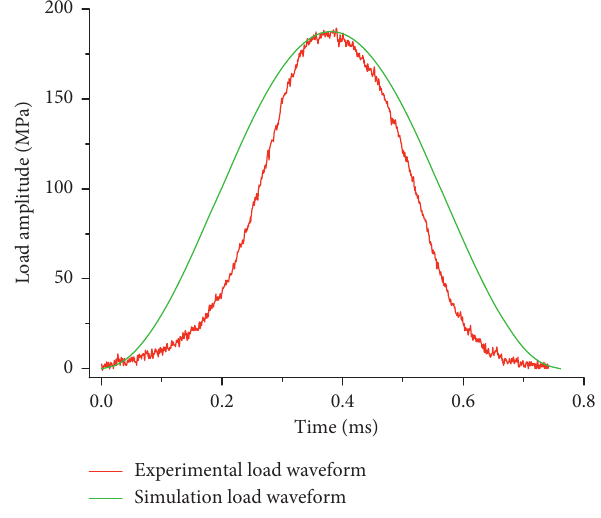
Figure 9: Test and simulation input load curve.